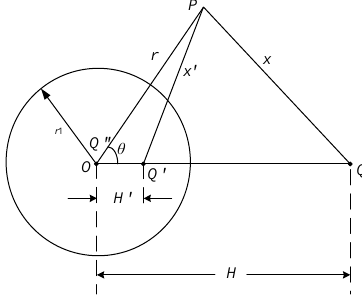
Figure 3. Sketch of calculation for the electric field.